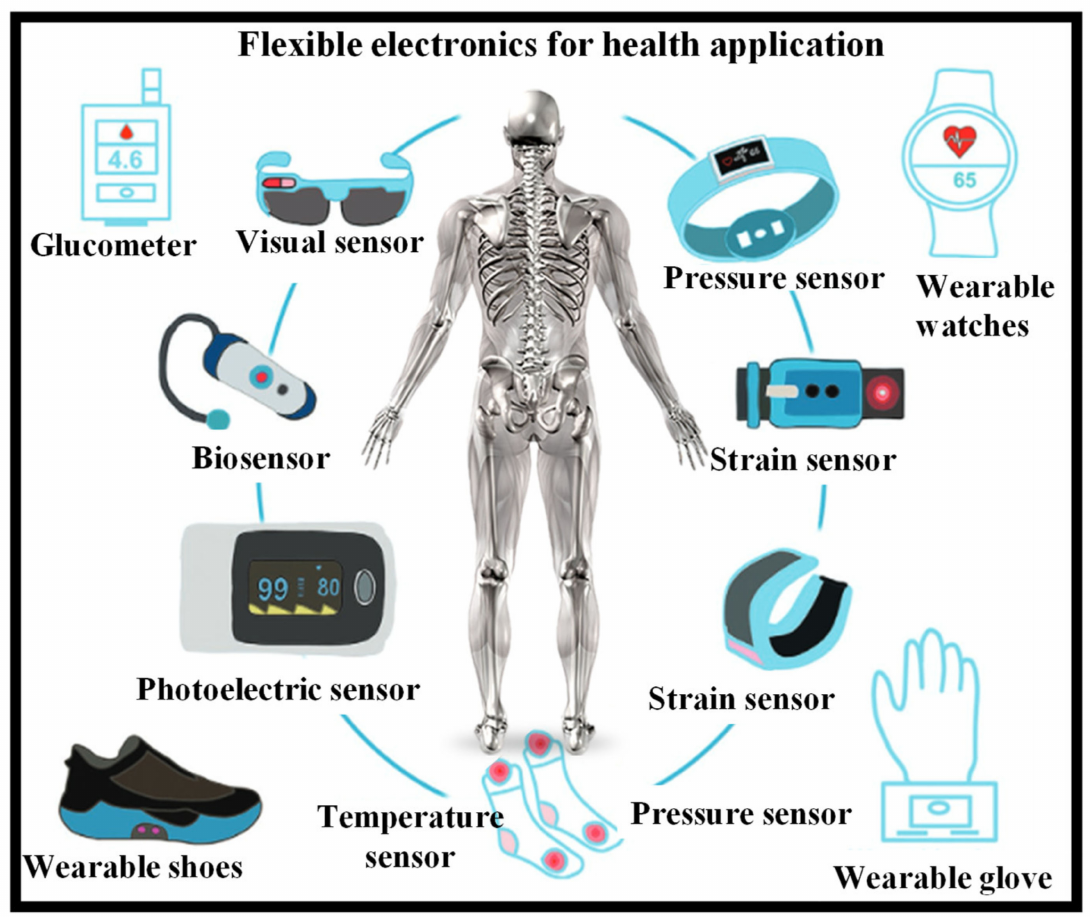
Figure 1. Schematic of flexile electronics for personal healthcare. Inspired by the work in